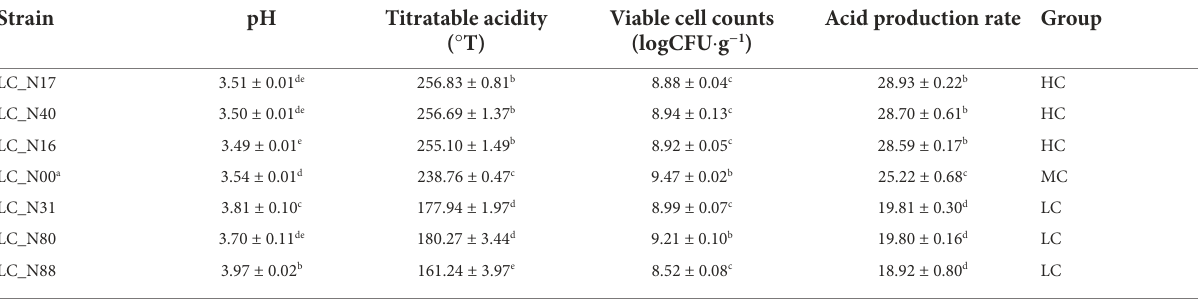
TABLE 1 Acid production rates of exemplar L. casei strains from the high acid (HC) and low acid (LC) groups. Strain pH Titratable acidity